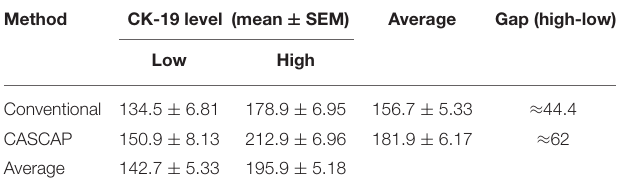
TABLE 5 | Comparison of CK19 level and gap between subgroup of new (CASCAP) and conventional (CV)